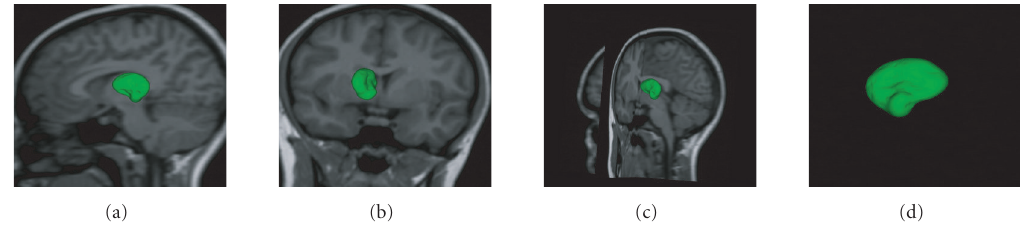
Figure 4: (a)–(c) Three di ff erent views of the final shape of the 3D thalamus; and (d) a close-up view of the